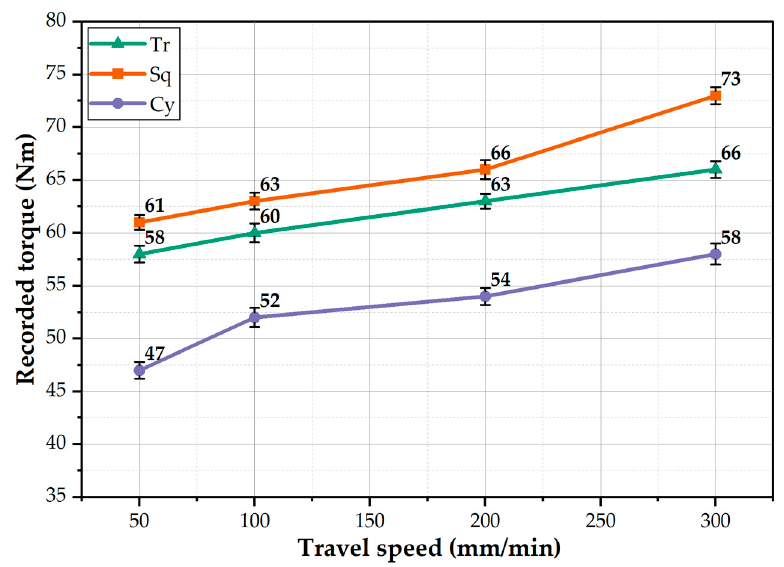
Figure 10. The average recorded torque as a function of processing travel speed at different pin geometries.